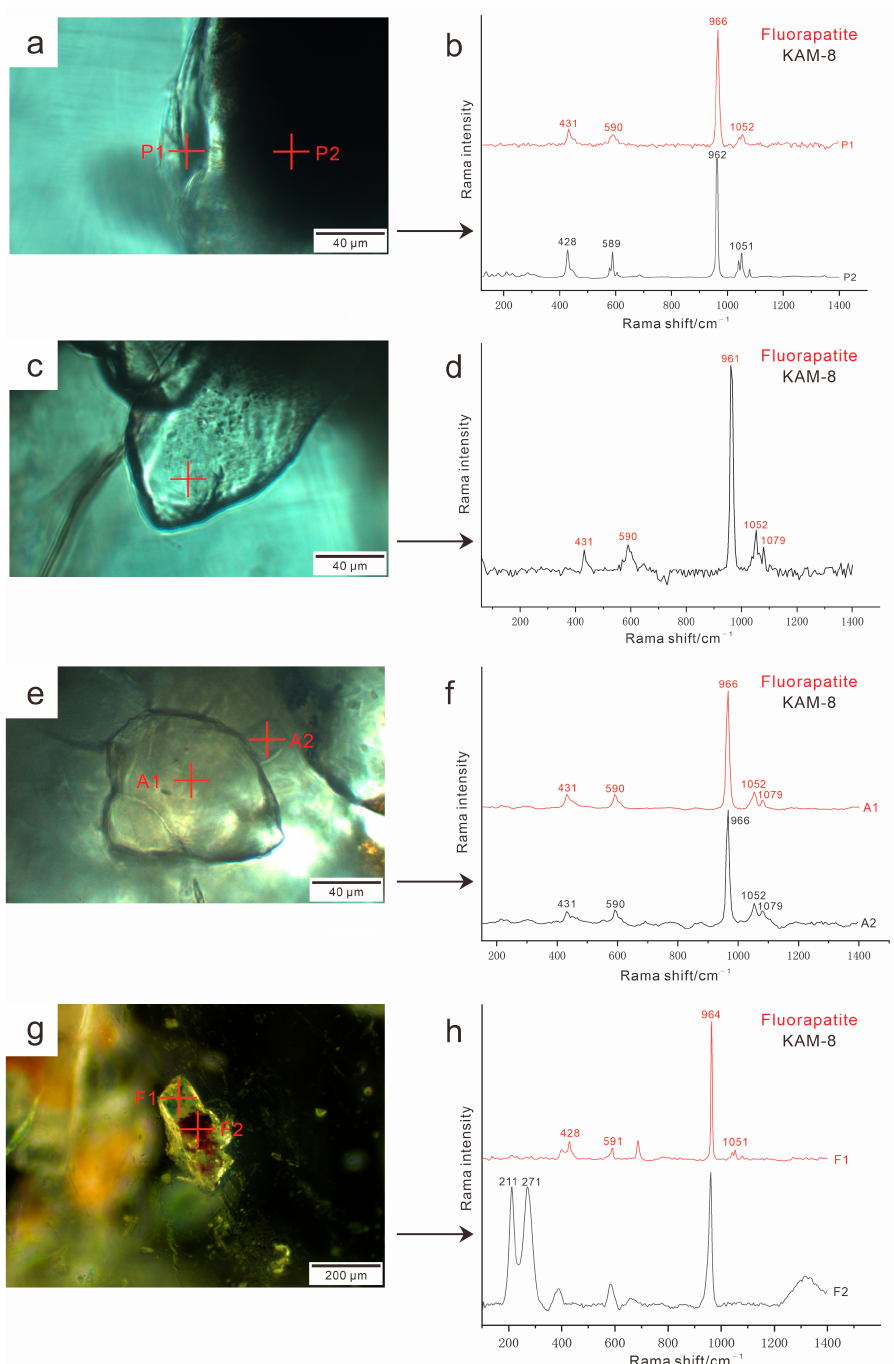
Figure 8. ( a – h ) Four typical fluorapatite inclusions in Kamakanga emerald (KAM-8) were tested by Raman spectroscope. The results are shown on the right.